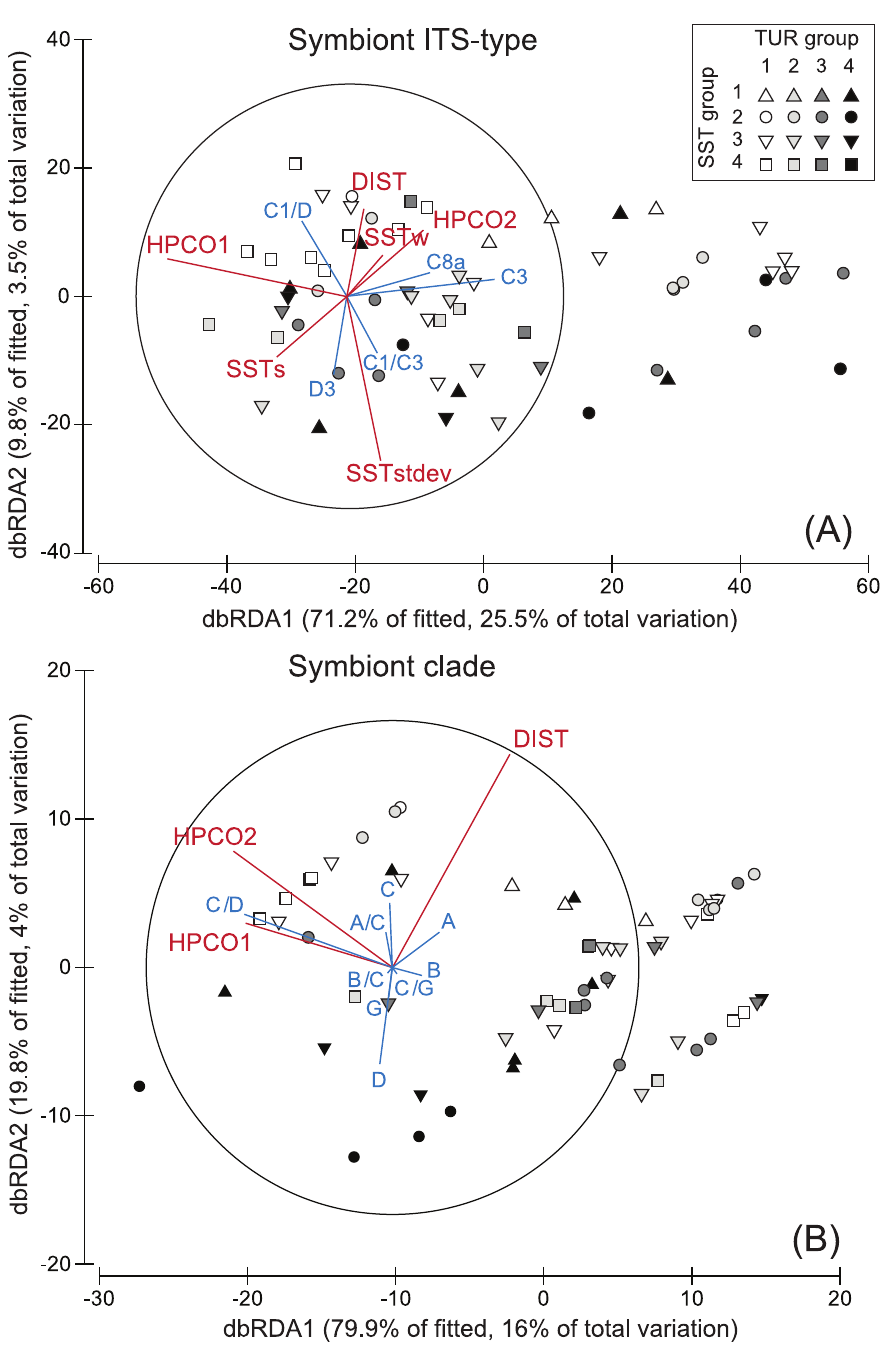
Figure 5. DbRDA ordination relating environmental variables to Symbiodinium ITS-type data of all host species combined. Presence/ absence data of Symbiodinium ITS-types (A) and presence/absence data of Symbiodinium summed by clade (B) showing biplot projections (r . 0.3) for environmental data (red; including the host variation expressed as HPCO1 and HPCO2) and symbiont types (blue). Sites are designated a sea surface temperature (SST) group (indicated by symbols) and turbidity (TUR) group (indicated with different shades of grey). The ‘% of fitted’ indicates the variability in the original data explained by the fitted model and ‘% of total variation’ indicates the variation in the fitted matrix.